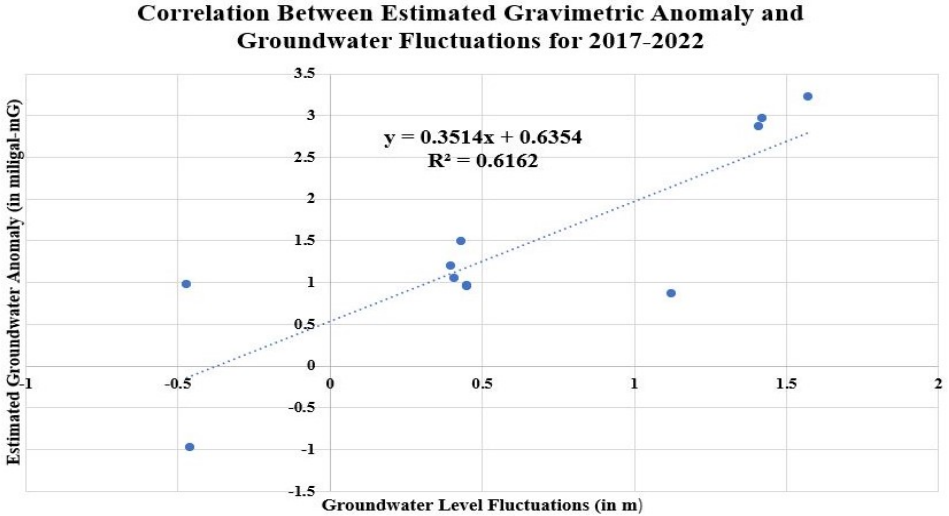
Figure 8. Correlative plot of groundwater level fluctuations from wells across the study area with GRACE data-based average gravimetric anomaly from 2017 to 2022.